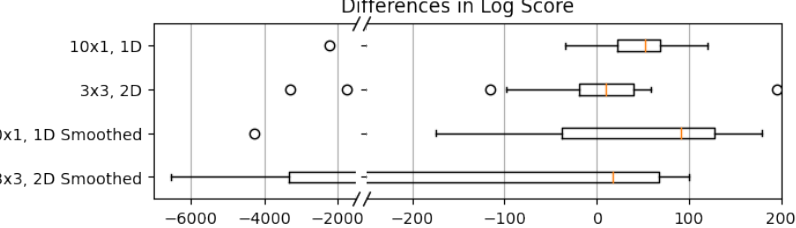
Figure 6. The top box plots show the difference in log score between the spatial and independent models across 25 simulations. The ( 25%,50%,75% ) quantile values are ( 21.8,52.8,69.1 ) for the 1D case and ( − 19.2,10.4,39.6 ) for the 2D case. The two lower box plots show the difference in log score between the spatial and smoothed independent model. Quantiles are ( − 37.9,91.8, 128.0 ) and ( − 3326.4,16.9,67.3 ) for 1D and 2D respectively. Note the discontinuous